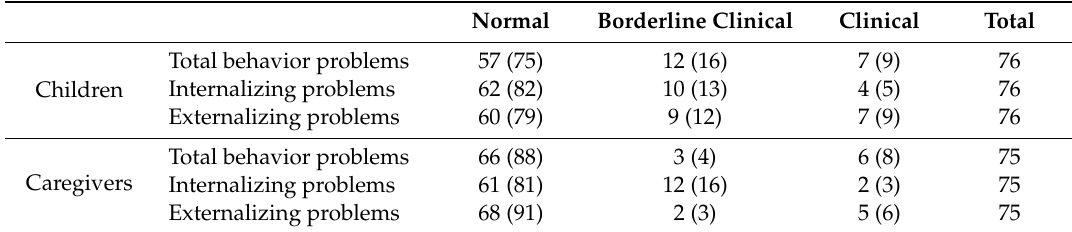
Table 2. Prevalence of behavior problems in children and caregivers.